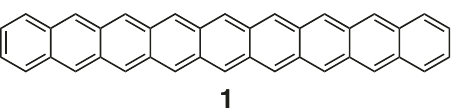
Fig. 1 Molecular structure of nonacene 1. This topological representation shows one of the nine Clar ’ s structures with one single aromatic